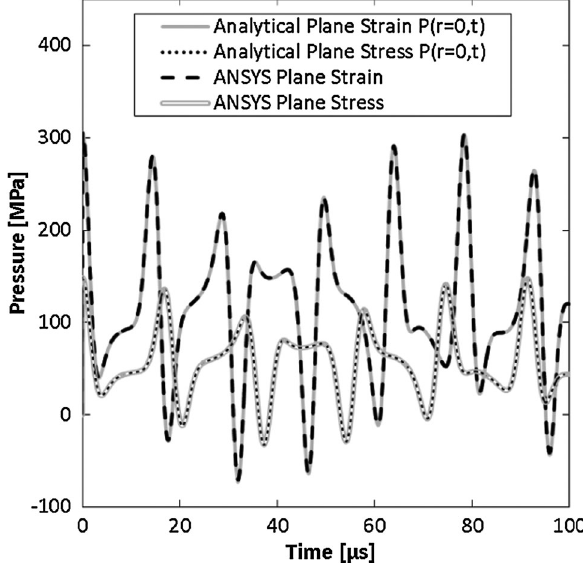
FIG. 12. Comparison of plane stress model representing a foil or window and plane strain representing a long